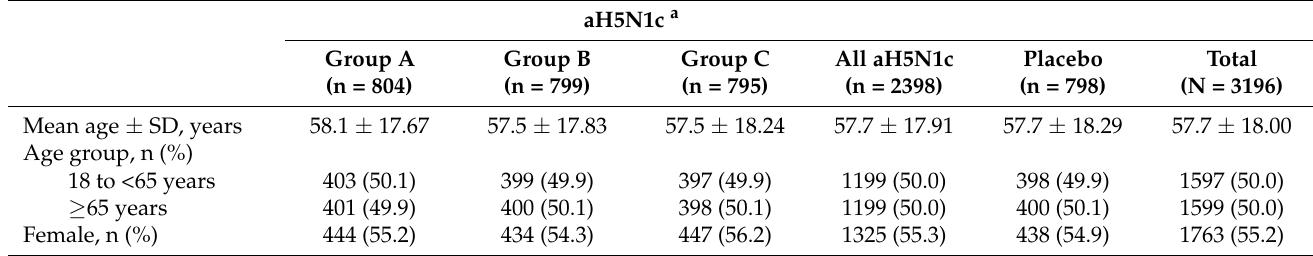
Figure 1. Disposition of subjects. a Includes subjects for whom blood was drawn but not on Day 1. b Includes subjects for whom blood was drawn out of the time window specified in the protocol. Table 1. Baseline demographics and characteristics in the enrolled